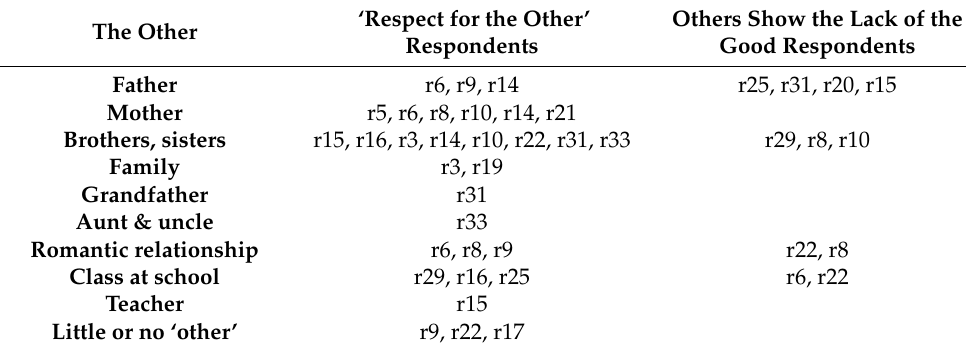
Table 1. Respect for the other in the first life